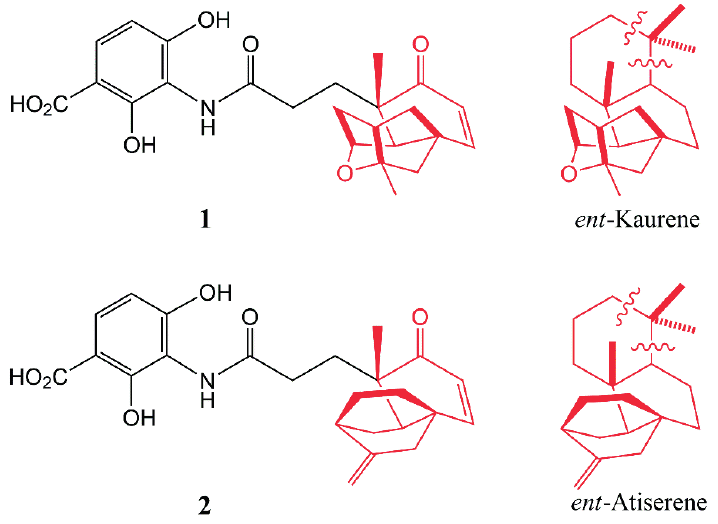
Figure 1. Structures of platensimycin 1 and platencin 2 and their biosynthetic relationship to ent -kaurene and ent